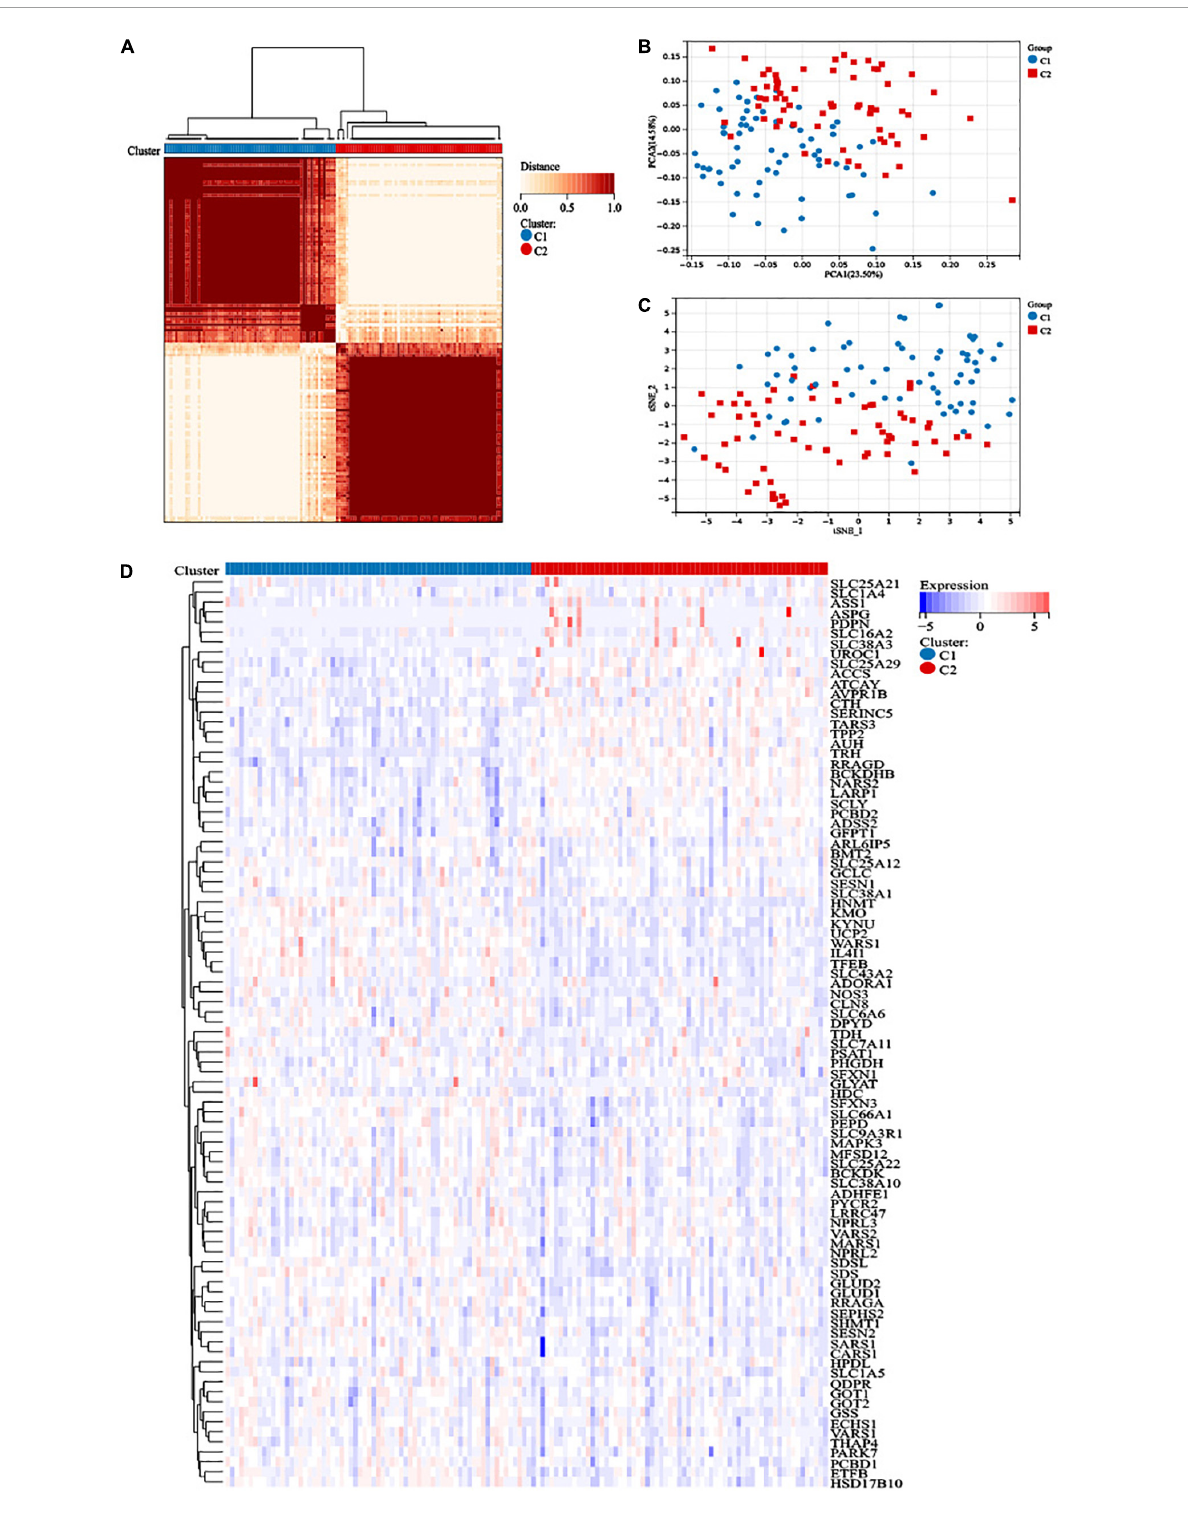
FIGURE1 Construction of distinct amino acid metabolism-related clusters. (A) The consensus clustering matrix divided 132 acute myeloid leukemia (AML) patients into two clusters ( k = 2). (B) Principal component analysis (PCA) analysis and (C) t-distributed stochastic neighbor embedding (t-SNE) analysis showed distribution difference between the two clusters. (D) Heatmap of the 91 amino acid metabolism genes in the two